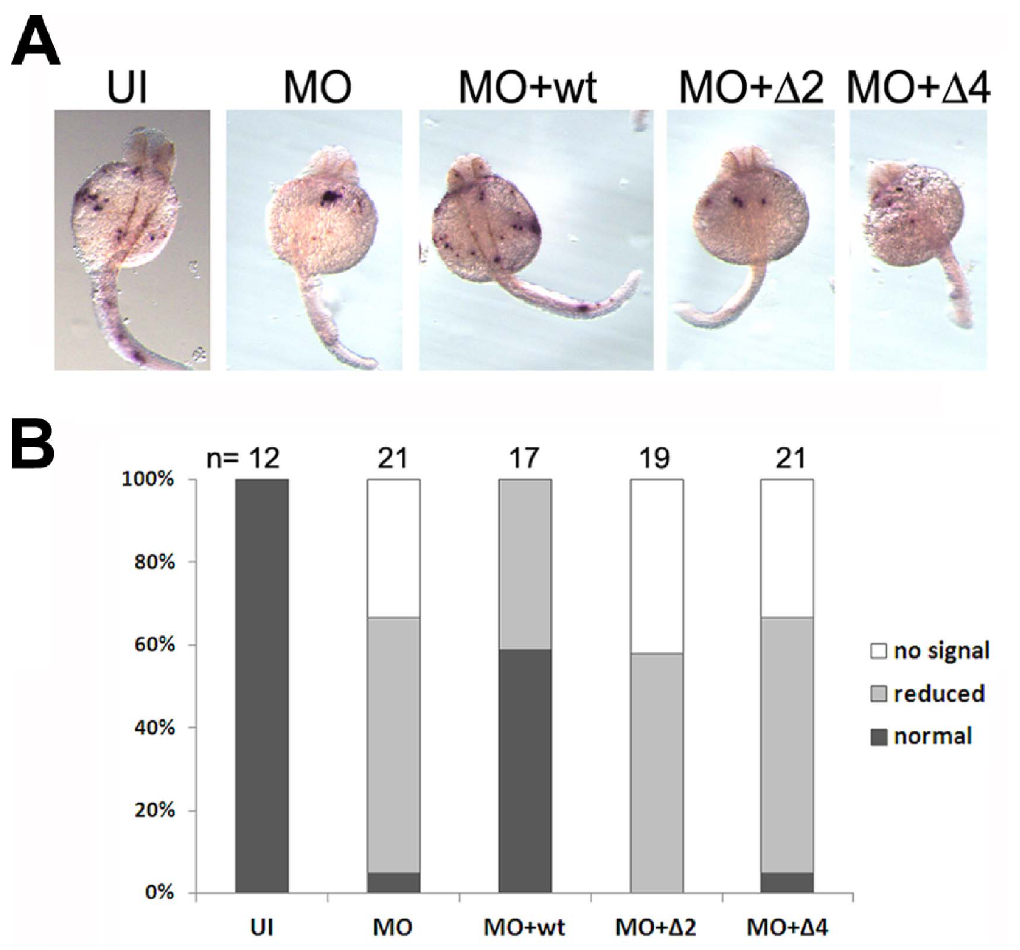
Figure 5. Testing the ability of mutant RNAs to rescue the MO knockdown phenotype. (A) Whole mount in situ hybridization of wild type and mutant embryos at 30 hpf for mpo . (B) MZ pak4 knockdown-rescue data. Percentages of embryos showing undetectable, reduced or normal staining as compared to control for mpo expression at 30 hpf in (A). UI, uninjected wild type EK. MO, 6 ng pak4 MO cocktail. MO + wt, 6 ng pak4 MO cocktail plus 800 pg wild type PAK4-eGFP RNA. MO + D 2, 6 ng pak4 MO cocktail plus 800 pg PAK4 D 2-eGFP RNA. MO + D 4, 6 ng pak4 MO cocktail plus 800 pg PAK4 D 4-eGFP RNA. Only the wild type pak4 RNA resulted in significant rescue of mpo expression. doi:10.1371/journal.pone.0100268.g005 and mutant embryos ( pak4 D 2/ D 4, F 3 ) at the 1-cell stage, at the same dose as used for the pak4 MO cocktail (6 ng). As shown in Figure 6A, this had no effect: both sets of embryos developed normally into feeding larvae. Second, we tested thermal stress. Zebrafish embryos develop normally between 23 u C and 33 u C.